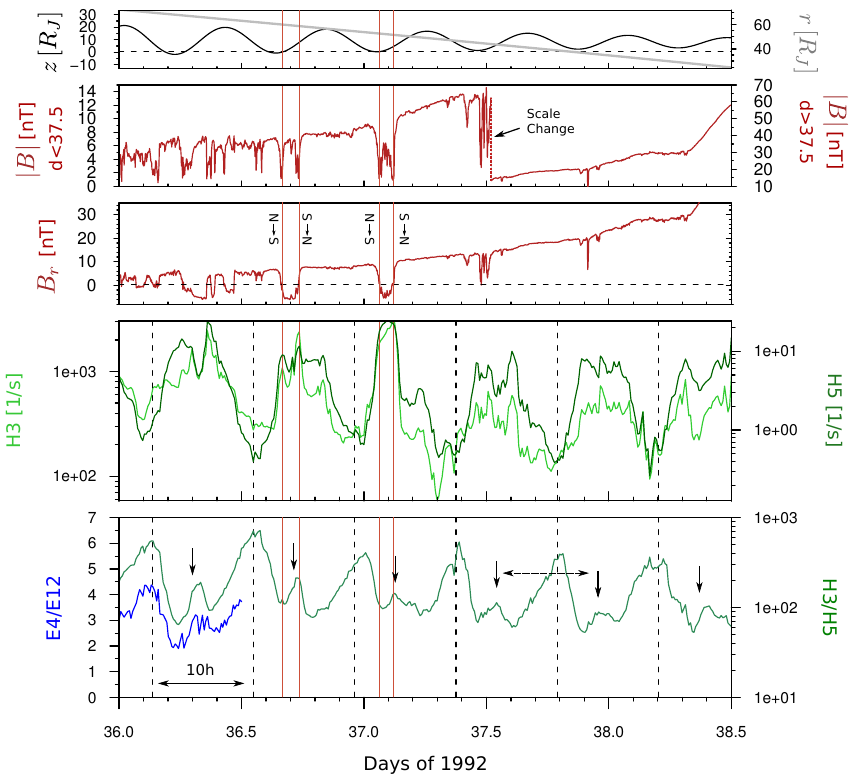
Fig. 3. Same as Fig. 2 but for the time interval day 36 to 38.5. The major and minor peaks are still present. Four current sheet crossings are indicated by the red vertical lines and reveal that the minor peaks occur when the spacecraft moves across the current sheet from south to north. Note the scale change in | B | at day 37.5.